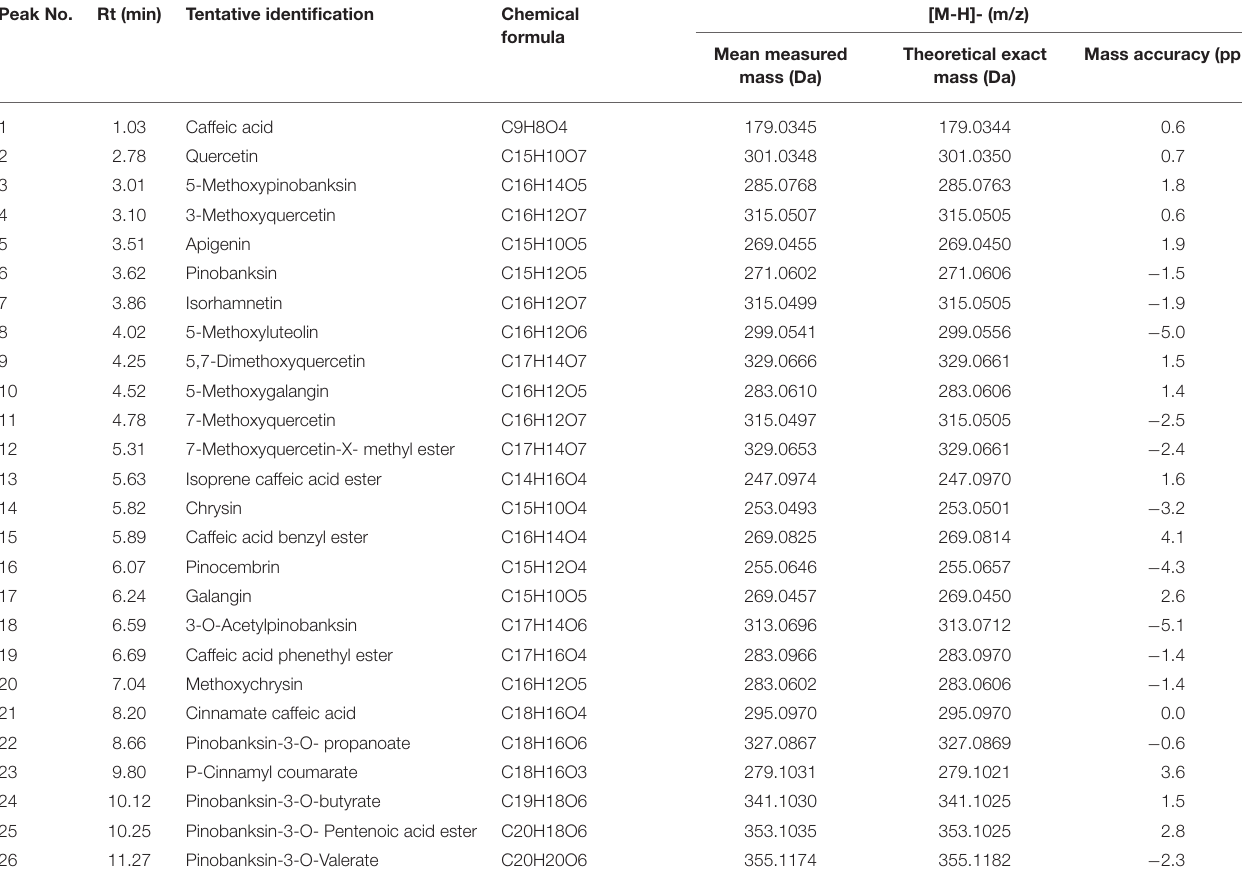
TABLE 1 | Identification of compounds in ethanolic crude extract from propolis of Melipona quadrifasciata by UPLC-MS analysis. Peak No. Rt (min) Tentative